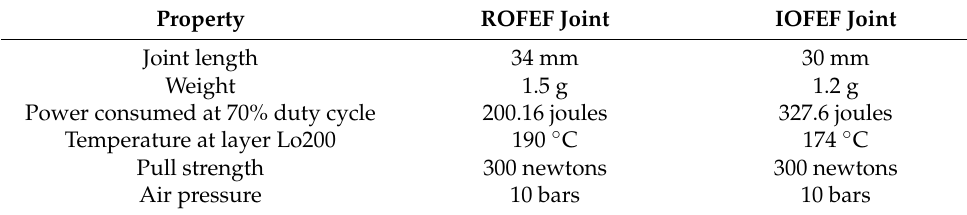
Table 3. Comparison of ROFEF and IOFEF joint. Property ROFEF Joint IOFEF Joint Joint length 34 mm 30 mm Weight 1.5 g Power consumed at 70% duty cycle 200.16 joules 327.6